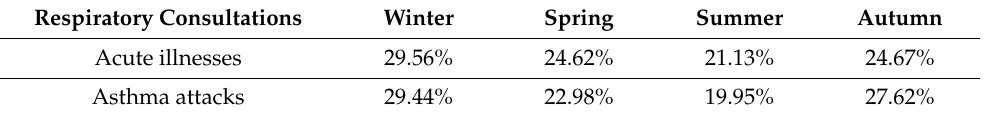
Table 4. Reasons for consultation in subjects aged five years and older by season.